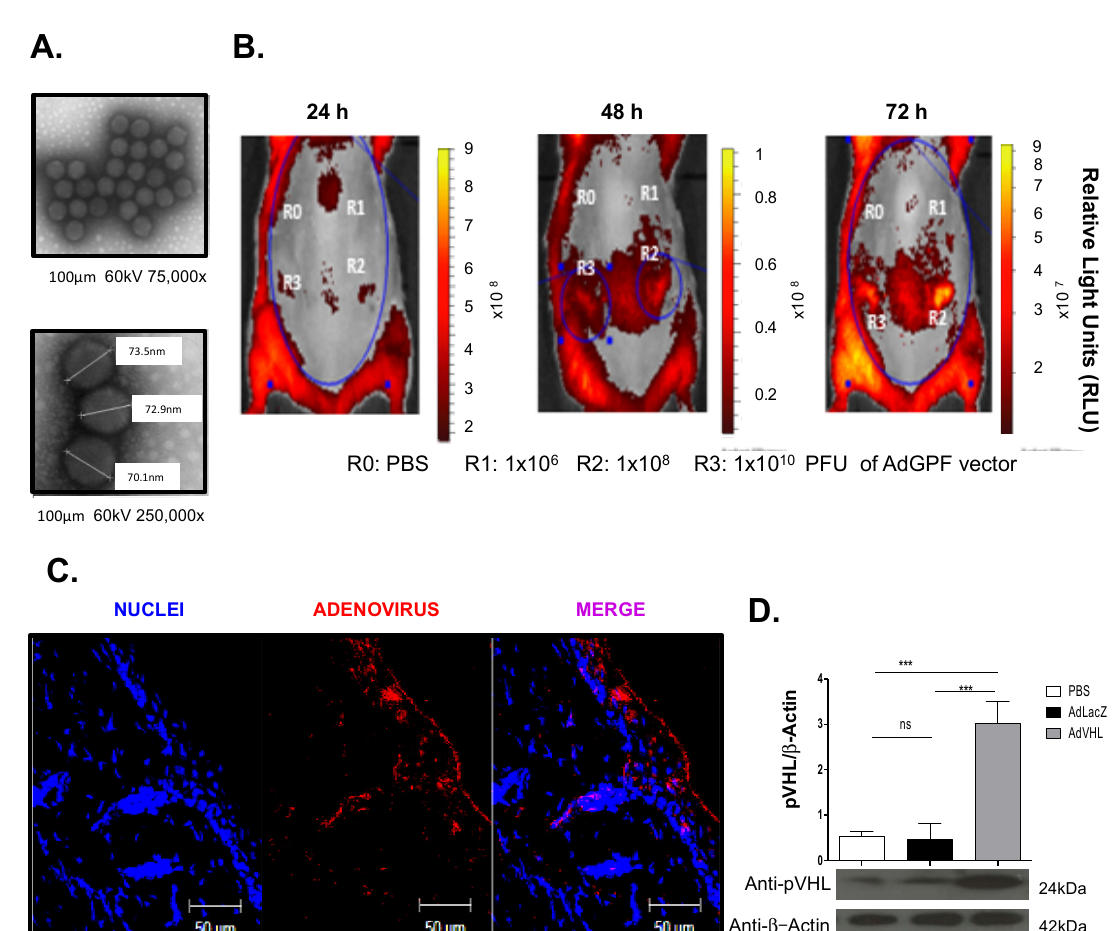
Figure 2. Expression of pVHL and GFP in normal skin of mice treated with adenoviral vectors . ( A ) Representative transmission electron micrographs of adenoviral particles that display a hexagonal shape of approximately 70 nm, 75,000× (upper image) or 250,000× (lower image) magnification. ( B ) Representative images from in vivo imaging of GFP expression. Intradermal injection of R0: PBS, R1: 1 × 10 6 , R2: 1 × 10 8 or R3: 1 × 10 10 PFU of AdGFP in four different regions of the backs of mice. GFP expression was evaluated at 24, 48 or 72 h after infection; color bar indicates the intensity of relative light units (RLU). ( C ) Representative confocal micrographs from skin infected with 1 × 10 10 UFP of AdLacZ. Images show the adenoviral particles (red), nuclei (blue) and merge (magenta). ( D ) Western blot analysis of pVHL expression in skin treated with AdLacZ or AdVHL vectors. Bar graphs shows the results obtained from four independent experiments, band intensity images are representative of one experiment and β -actin was used a control load, two-way ANOVA with post hoc Tukey’s test. *** p > 0.001. Scale bar = 50 μ m. Ad: Adenoviral vector. pVHL: von Hippel-Lindau protein, GFP: Green Fluorescent Protein, PFU: Plaque-Forming units.